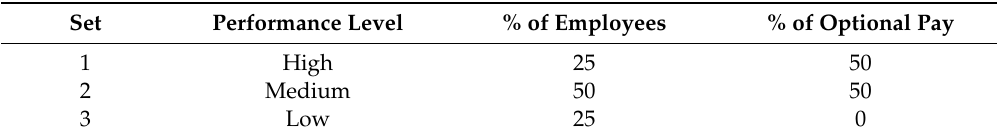
Table 1. Employees sets according to L.D. 150 /